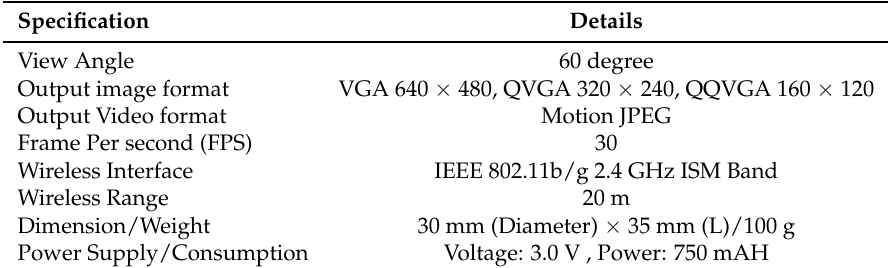
Table 1. Artificial Intelligence (AI) ball camera specification.